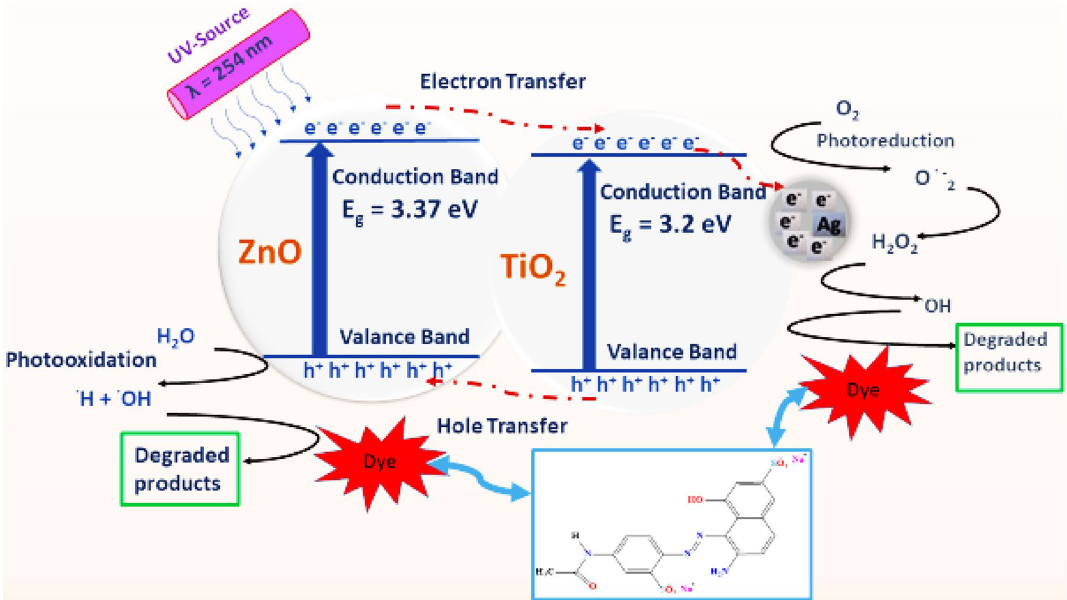
Figure 12. Proposed mechanism of the investigated dye degradation using UV/(TiO 2 –ZnO & x Ag NPs)